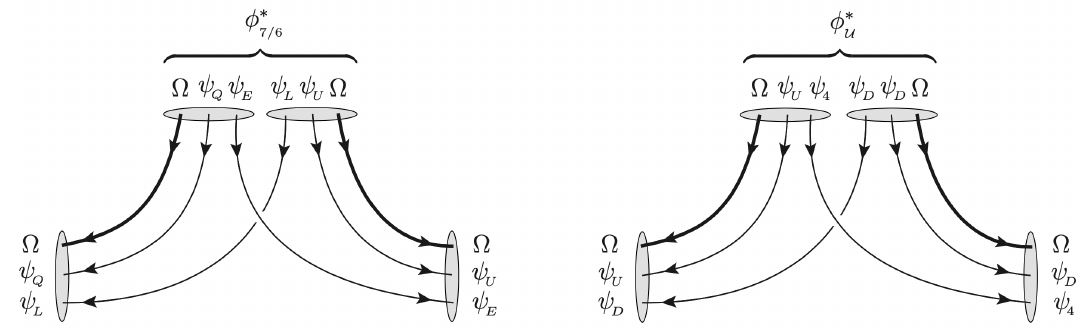
Figure 1 . Yukawa couplings of the down-type weak-singlet Vquarks of components Ω (3 , 1) Ω UE and Ω D 4 to the composite scalars φ